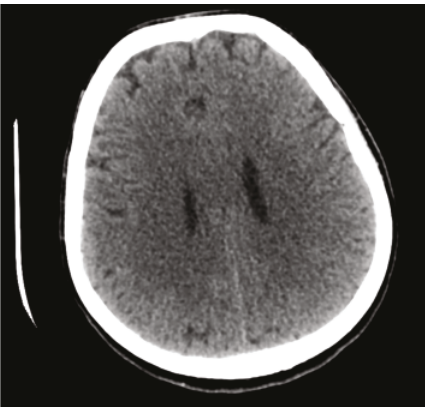
Figure 1: Noninjected CT-scan realized on the day of admission.